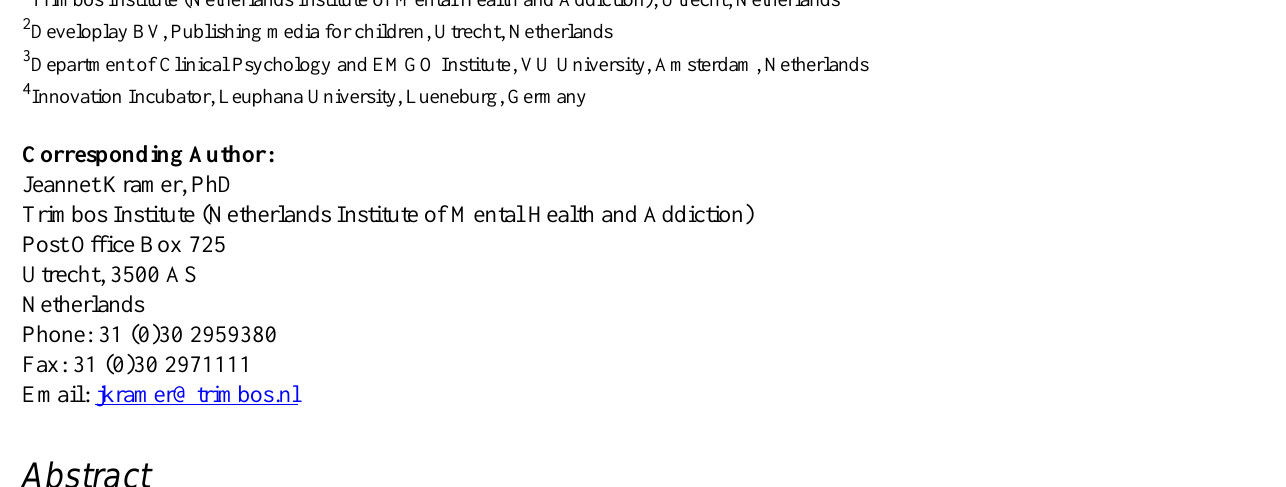
depression; randomized controlled trial; Internet; Solution Focused Brief Therapy; young